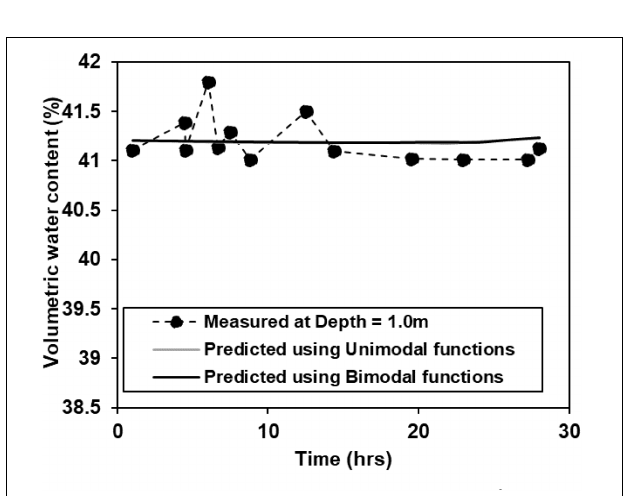
FIGURE 10 | Comparison between measured and predicted ( k sat = 10 − 3 m/h for unimodal function) volumetric water content at the depth of 1.0